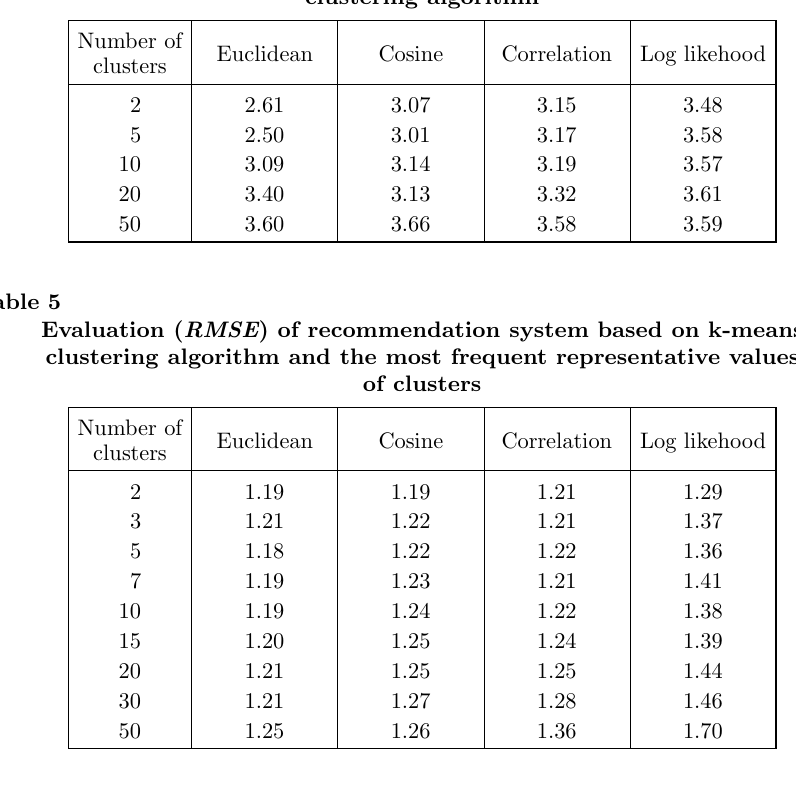
Evaluation ( RMSE ) of recommendation system based on k-means clustering algorithm